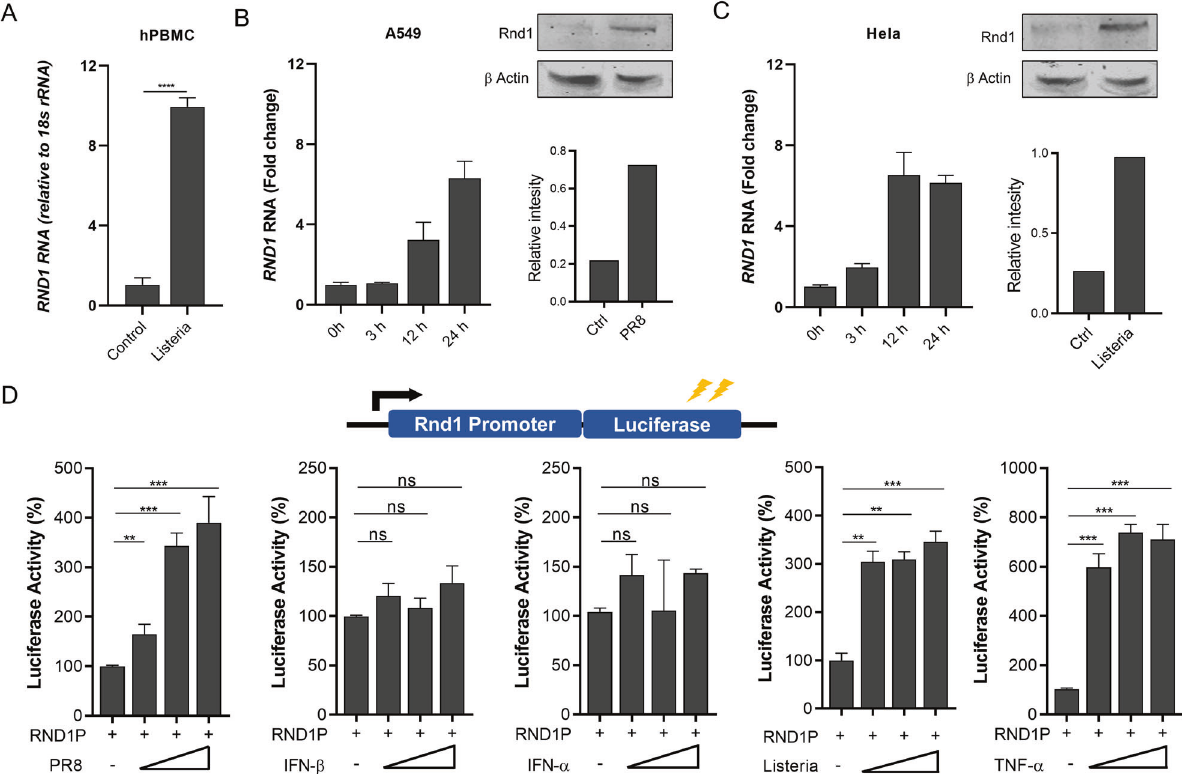
Fig. 1 Induction of Rnd1 during viral and bacterial infections. A peripheral blood mononuclear cells (PBMCs) were infected with Listeria monocytogenes (LM) for 24 h and Rnd1 expression was analysed by RT-PCR analysis, B A549 cells were infected with PR8 or C Hela cells were infected with LM and expression of Rnd1 was analysed by RT-PCR after 0, 3, 12, and 24 h of infection or by western blotting using speci fi c antibody 12 h post infection. D Rnd1 promoter was cloned upstream to luciferase gene. The resulting plasmid (Rnd1P) was transfected into HEK293 cells, and luciferase activity was analysed 12 h after treatment with shown virus, bacteria or puri fi ed ligand. Cells were treated with 50, 100, 500 U/ml IFN- β , 100, 500, 1000 U/ml IFN- α , and 25, 50, 100 ng/ml TNF- α or infected with 0.5, 1, or 2 MOI of PR8 or LM. Data are representative of results from three independent experiments. RT-PCR and promoter reporter assay data are means ± SEMs from triplicate samples of a single